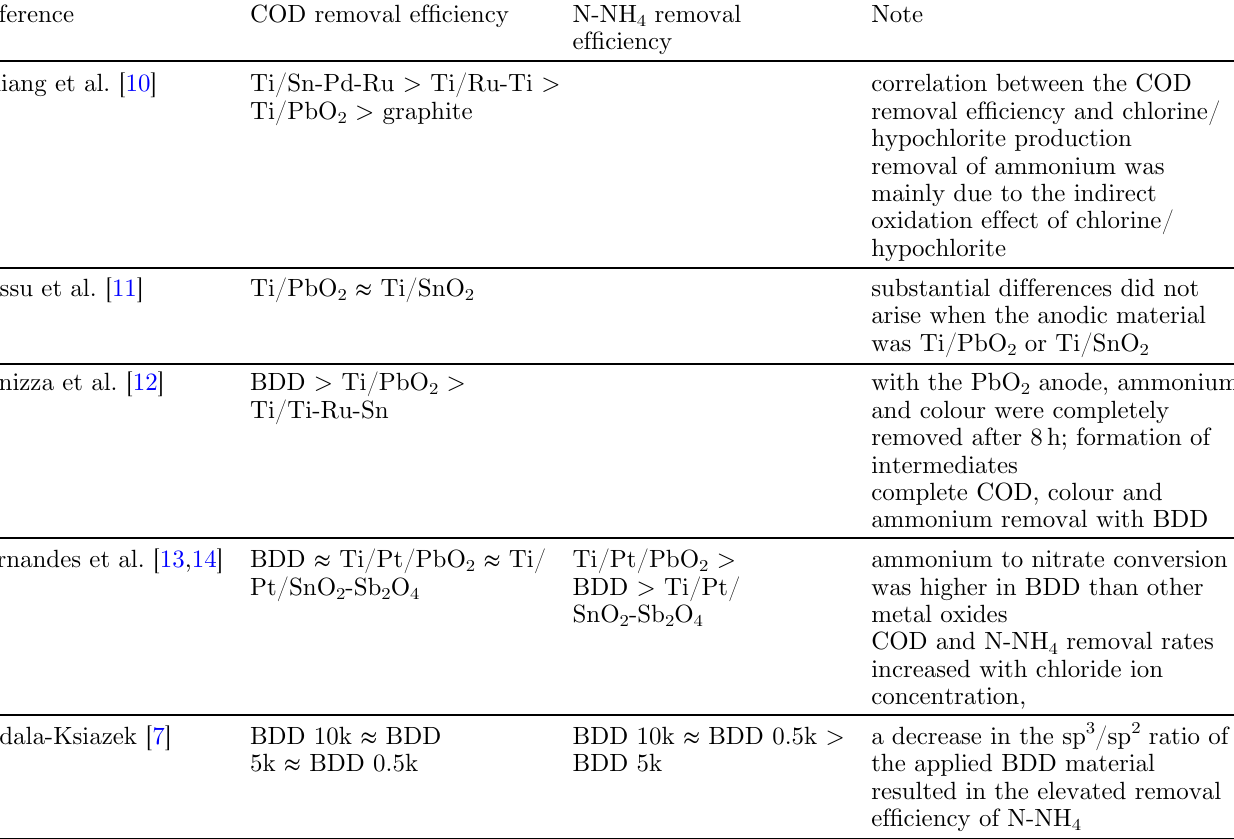
Table 3. Studies in which a material-based electrode investigation was performed for the electrochemical oxidation of land fi ll leachates.